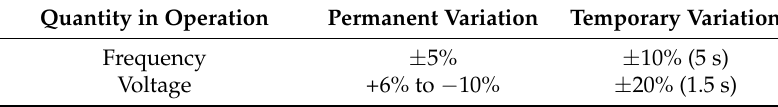
Table 4. Acceptable ranges of voltage and frequency variation for AC distribution